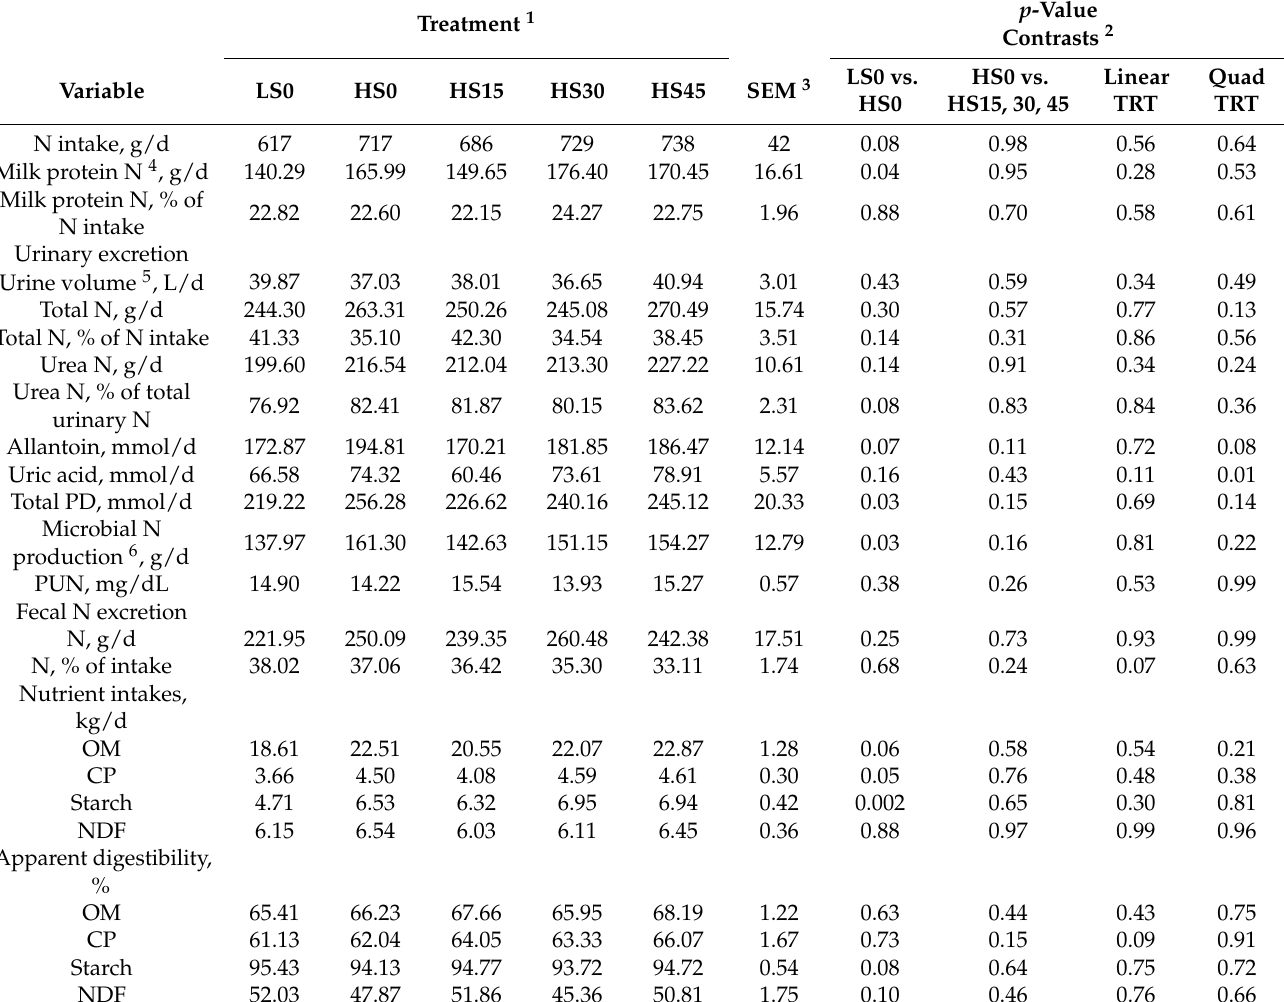
Table 5. Least squares means and associated SEM of nitrogen excretion and apparent digestibility in a low-starch diet without autolyzed yeast products (LS0), high-starch diet without autolyzed yeast products (HS0), HS with 15 g (HS15), 30 g (HS30), and 45 g (HS45) of autolyzed yeast during the experimental